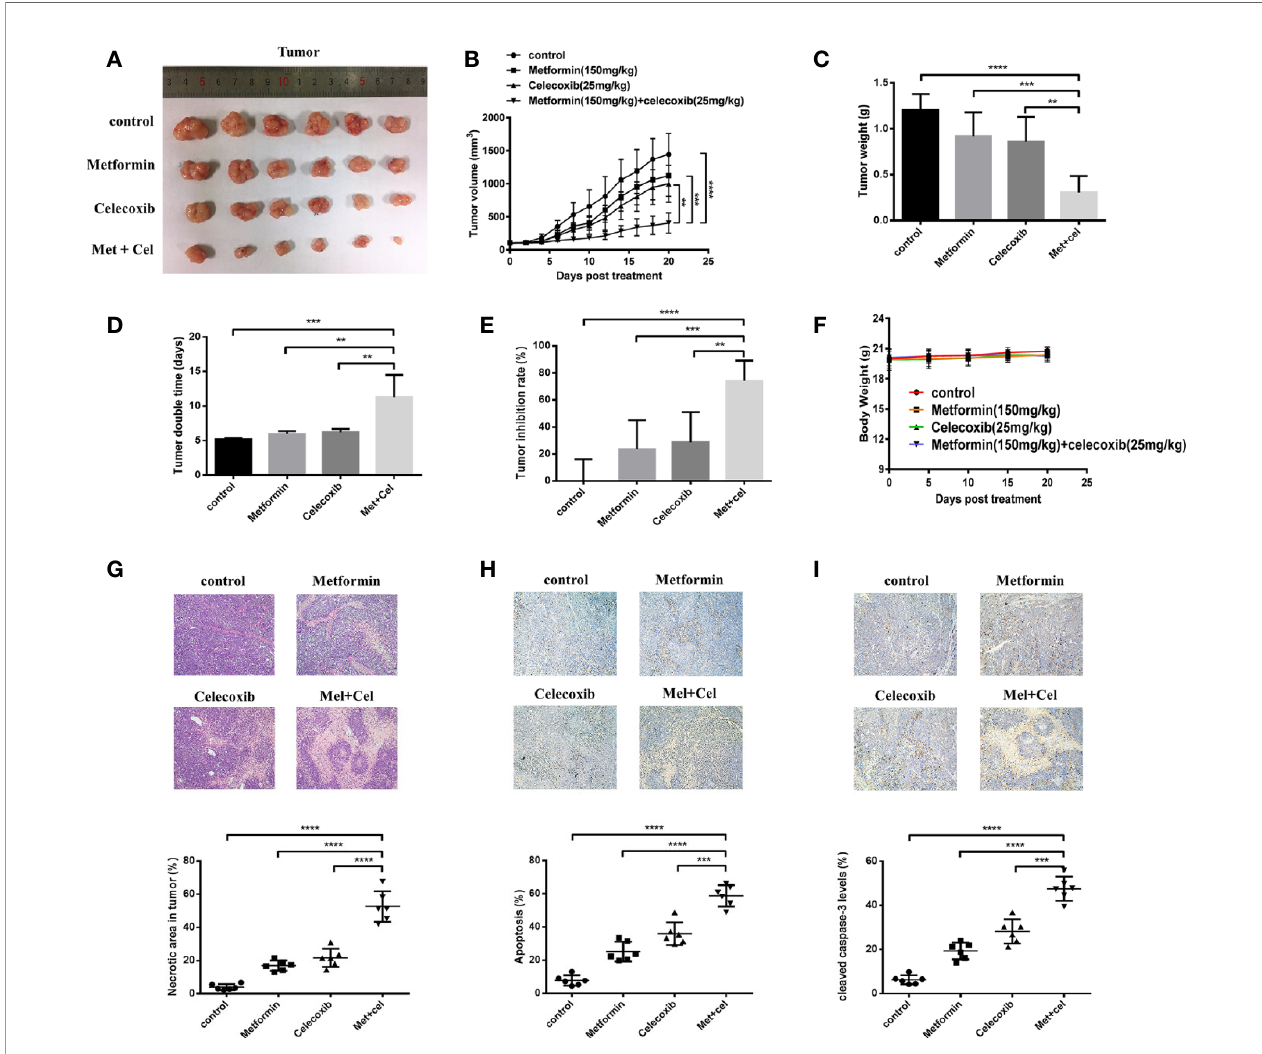
FIGURE 8 | Combined treatment with celecoxib and metformin inhibits tumor growth in A549 tumor-bearing nude mice. A549 cells were injected subcutaneously into the dorsal fl anks of athymic nude mice. When tumors reached a size of approximately 100 mm 3 , mice were gastrointestinal administrated with metformin (150 mg/kg/mouse) or intraperitoneally (i.p.) injected with celecoxib (25 mg/kg/mouse) or the combination of two drugs for a total of 20 days. (A) Representative images of the excised tumors from each therapeutic group were shown. (B) The tumor growth inhibitory effects of different treatments were compared. (C) At the end of the study, the excised tumors from each group were weighed. (D) Tumor doubling time of each therapeutic group. (E) Tumor inhibition rate of each therapeutic group. (F) Body weight change during treatment. (G) The necrosis changes of tumors receiving different treatments were observed by H&E staining. (H) TUNEL staining was applied to detect the apoptotic state of tumors receiving different treatments. (I) The amounts of cleaved caspase-3 were measured by immunohistochemistry. Quanti fi cation was followed by Image-J. Data are represented as mean ± SD. ** p < 0.01, *** p < 0.001, **** p <